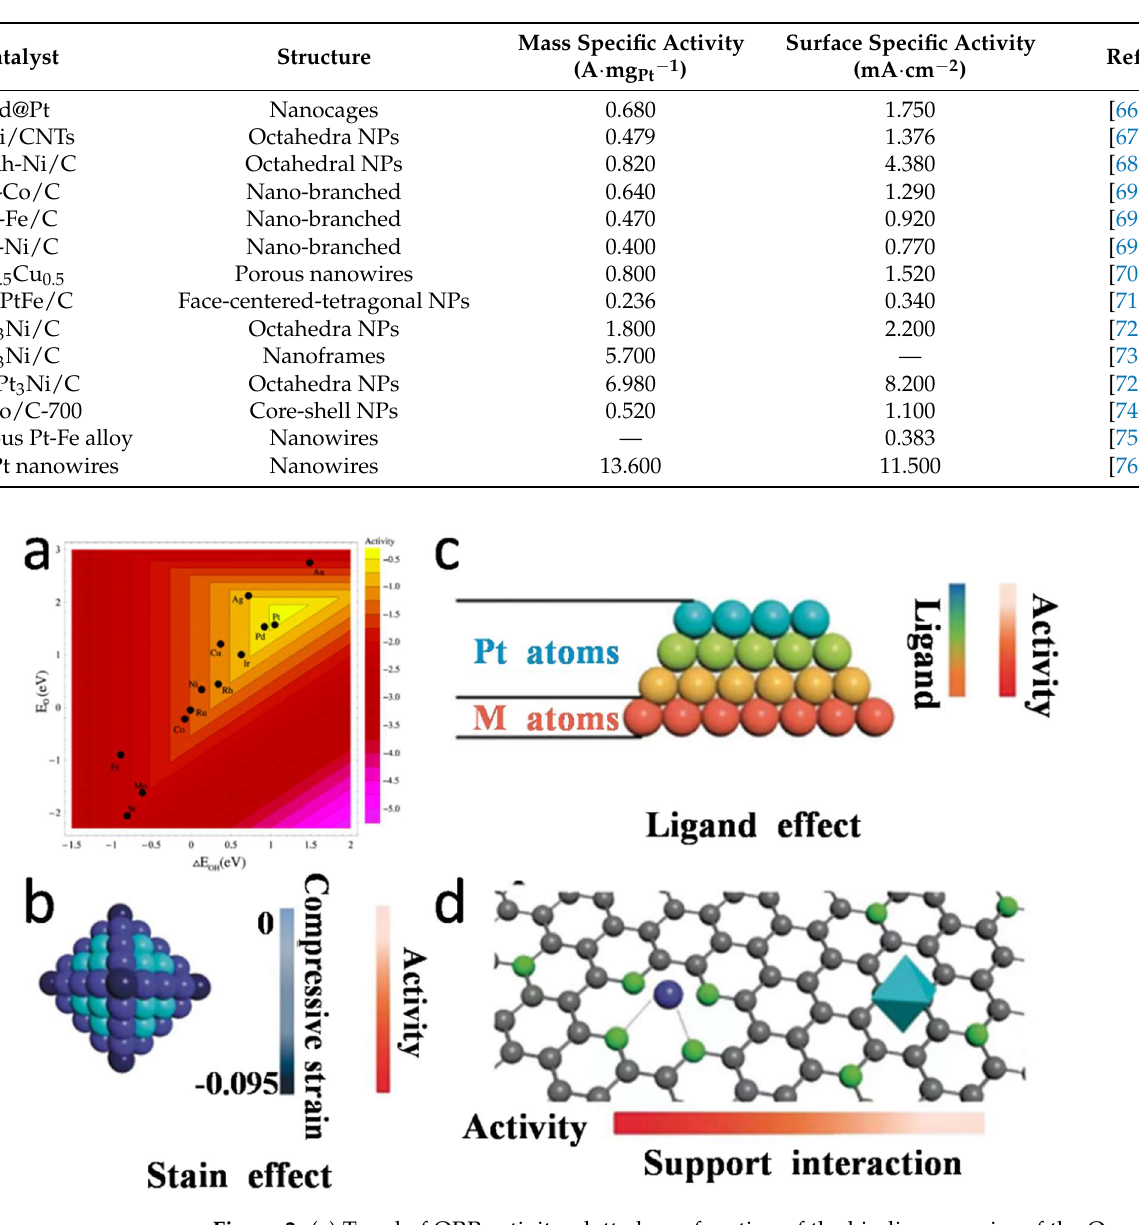
Table 1. The mass specific activities and surface specific activities of various Pt-based catalysts under 0.1 M HClO 4 . Values are recorded at 0.9 V vs. RHE.